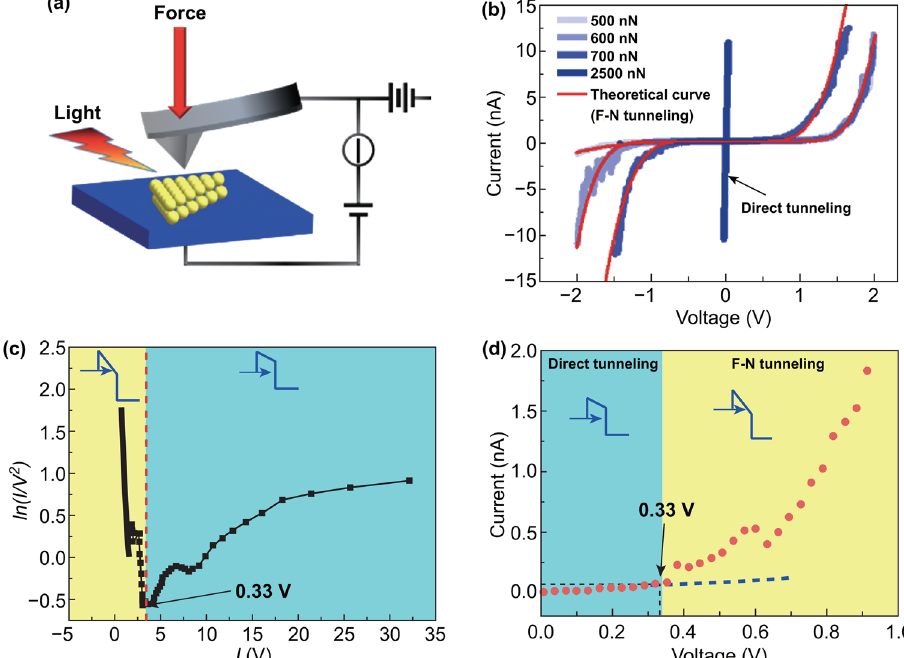
Fig. 13 Strain tuning vertical transport behavior by C-AFM mode. a Schematic of the measurement setup used to obtain the vertical electri- cal transport property curves of MoS 2 . b I – V curves measured under different force. c ln ( I / V 2 ) versus 1/ V curves and d local I – V curves in the forward bias for distinguishing between direct tunneling and F-N tunneling models. Reproduced with permission [180]. Copyright 2018, IOP